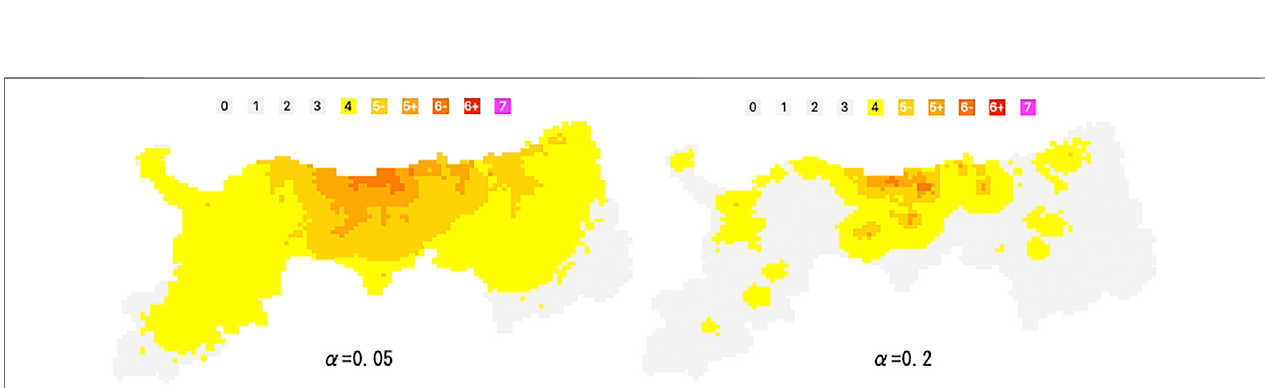
FIGURE 7 | Comparison of results with varying attenuation parameter α from the case of α (cid:2) 0.1 in Figure 5 .